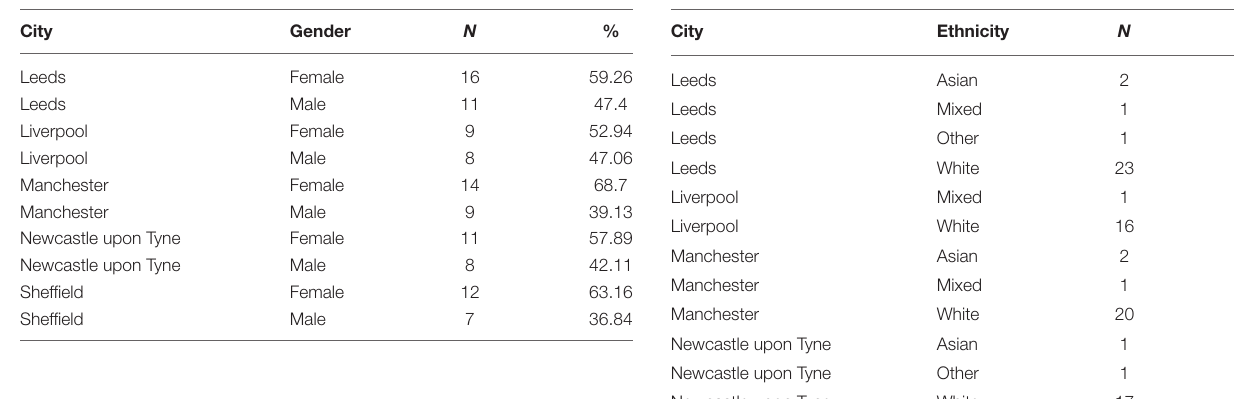
TABLE 1 | Summary of gender by city in our speaker sample. TABLE 2 | Summary of ethnicity by city in our speaker sample.